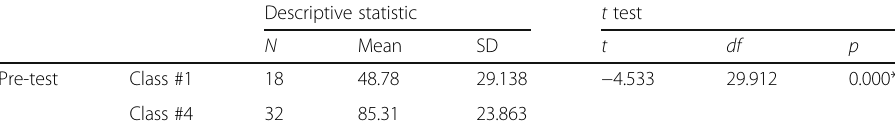
Table 13 Independent t test result for students ’ academic achievements in different groups Descriptive